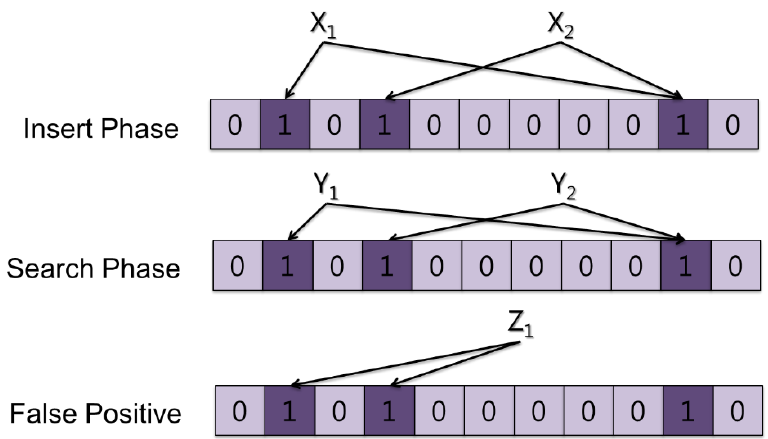
Figure 1. Simple operation of a Bloom